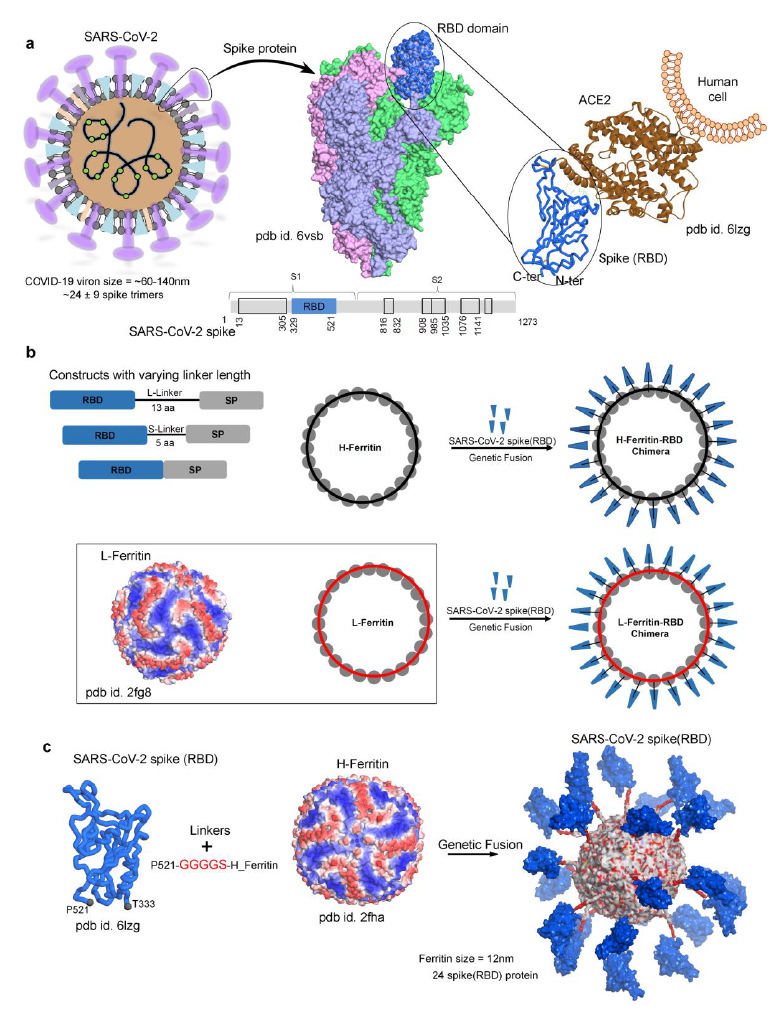
Figure 1. The construct of a SARS-CoV-2 spike receptor-binding domain (RBD) protein over the surface of a ferritin nanocage. ( a ) Spike proteins derived from the COVID-19 viron. A single viron’s size can be ~60–140 nm and consist of ~24 ± 9 spike homotrimers [29,37–39]. The crystal structures of a SARS-CoV-2 spike in its homotrimer state (pdb id. 6vsb [3]), as well as the monomeric spike RBD with the human angiotensin-converting enzyme 2 (ACE2) receptor (pdb id. cartoon representation of different chimeric constructs with varying lengths of linkers (No-Linker; 5 aa S-Linker, GGGGS; and 13 aa L-Linker, GGGSGGGGSGGGS), displaying the spike RBD monomers over two different ferritin nanocages (L- and H-ferritin). The individual subunits of ferritin (total twenty-four), represented as spheres, are connected to the RBD domain of the spike protein (magenta triangle) via the linker (black line). For the modeling of the L-ferritin nanocage, the crystal structure (pdb id. 2fg8 [33]) was used, and the cage was constructed using the Proteins, Interfaces, Structures and Assemblies (PDBePISA) server [40]. ( c ) An example of one of the spike RBD–ferritin nanocage systems (5 aa S-Linker chimeric construct). The spike RBD domain (24 monomers; pdb id. 6lzg [34]) is presented over the H-ferritin (pdb